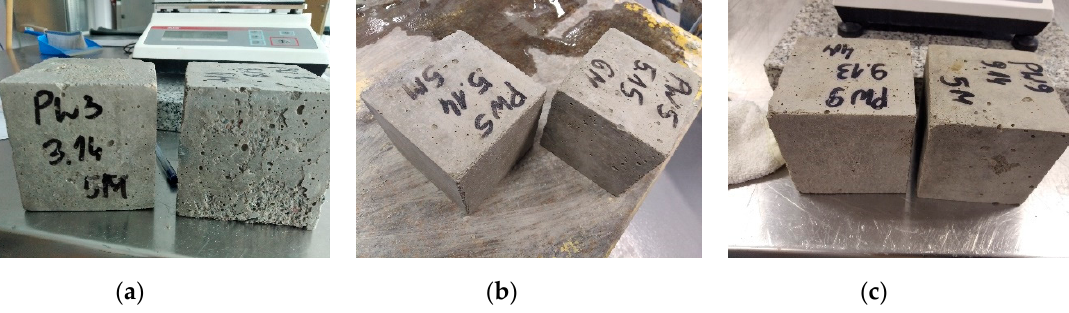
Figure 5. Specimens of concrete: PW3 ( a ), PW5 ( b ), and PW9 ( c ) after 100 freeze–thaw cycles.